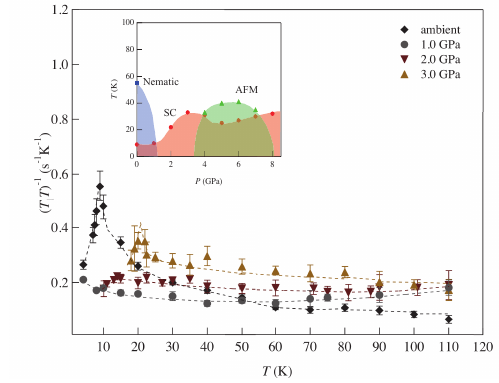
Figure 4: The T dependence of the relaxation rate di- vided by T , 1 /T 1 T . The dashed lines are a guide to the eye. The inset shows the phase diagram of FeSe 0 . 88 S 0 . 12 determined from the resistivity measurements